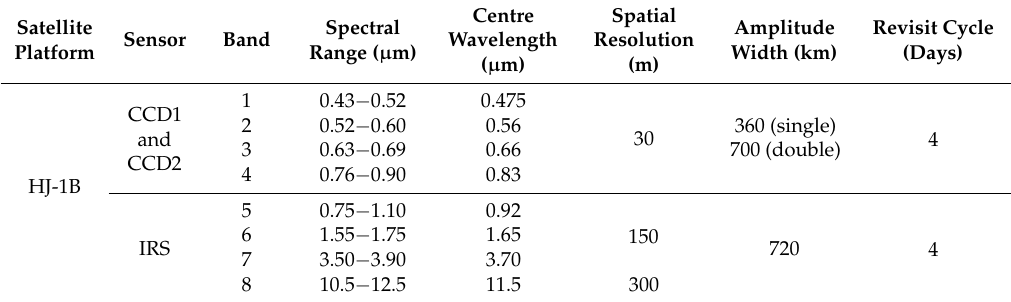
Table 1. HJ-1B satellite sensor parameters.